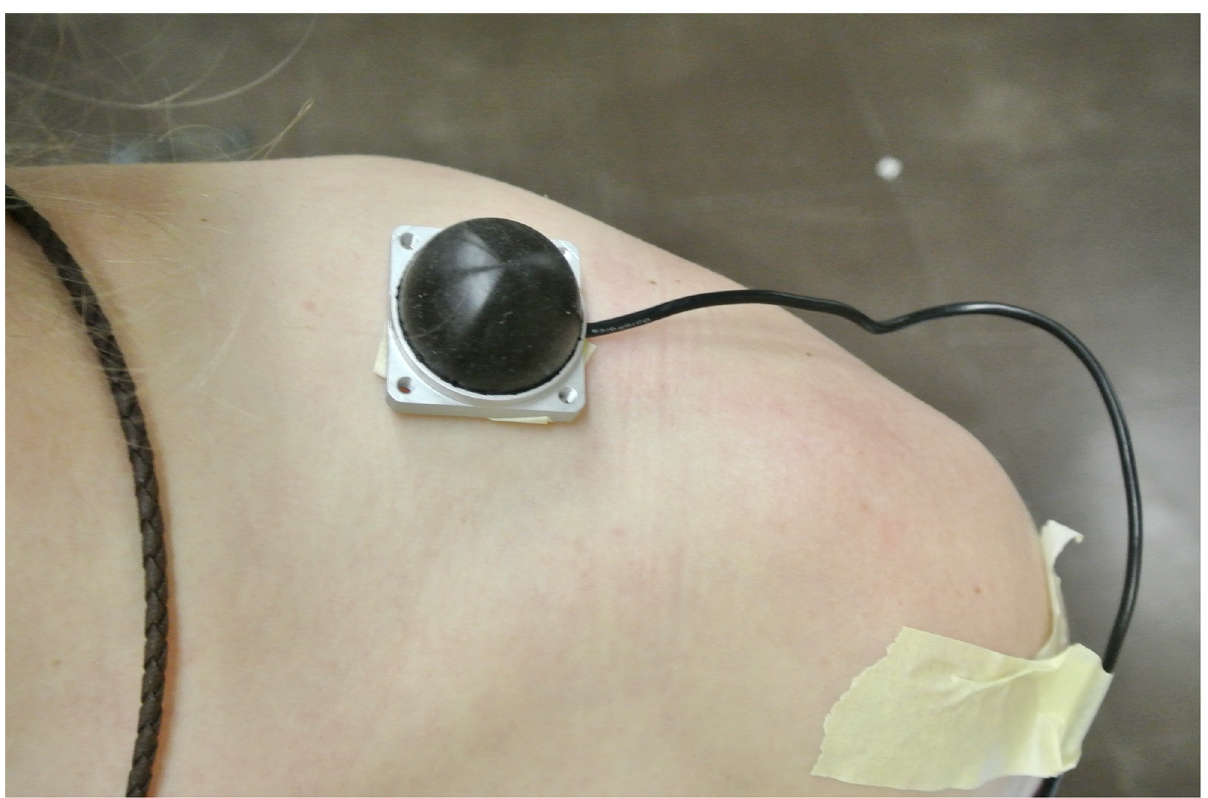
Fig 1. Pressure sensor on the left